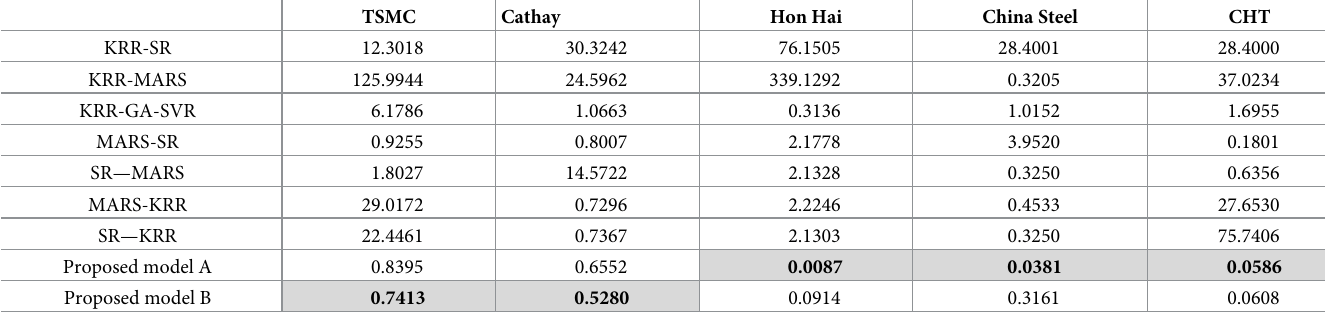
Table 17. The RMSE of all experiments for long testing